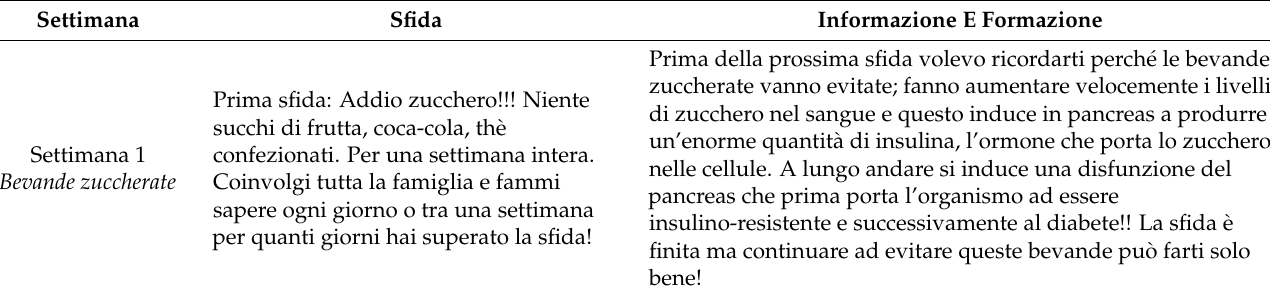
Table A4. Scheme of “Challenging messaging” (Italian